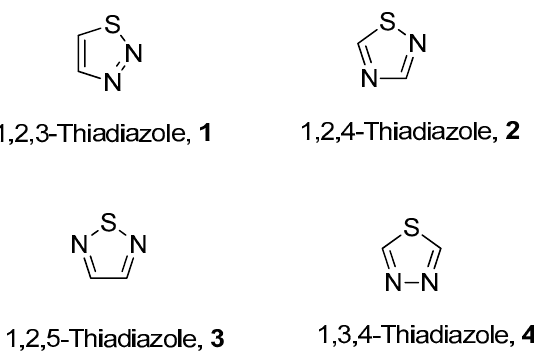
Figure 1. Structures of different isomeric forms of thiadiazole ( 1 – 4 ).